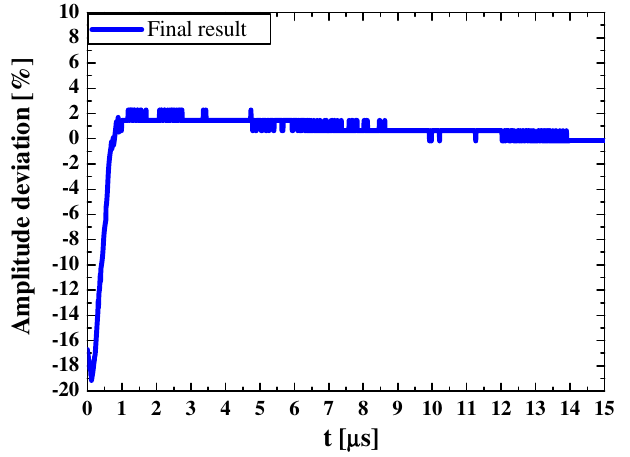
FIG. 16. (Color) Beam current profile measured by core moni- tors CM3 and CM4.